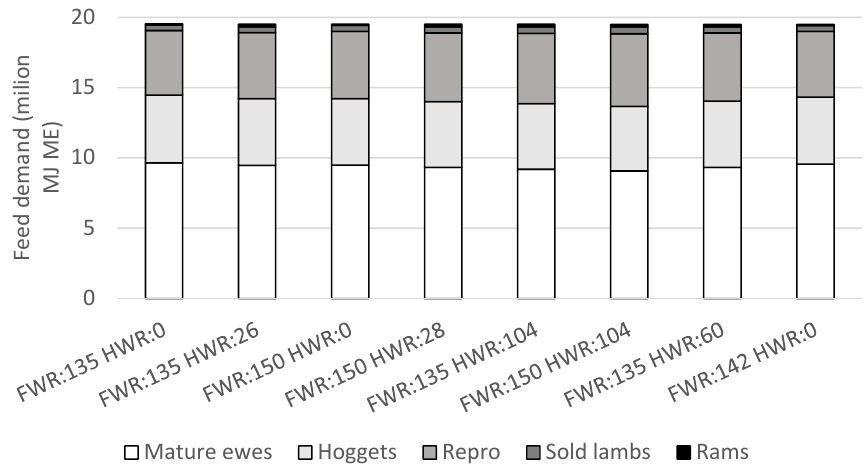
Figure 3. Annual feed demand (metabolisable energy) of mature ewes (2 to 6 years old), hoggets (1 year old ewes), reproduction (gestation and lactation of all lambs), sold lambs prior to leaving the farm, and rams, for scenarios with combinations of varying weaning rates (lambs weaned per ewe which was presented for breeding) of mature ewes (FWR) and hoggets (HWR).